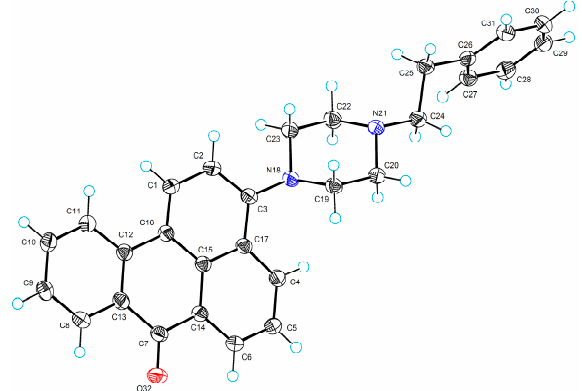
Figure 1. ORTEP diagram molecule 2 . Table 1. Selected torsion angles (°) for 2 .